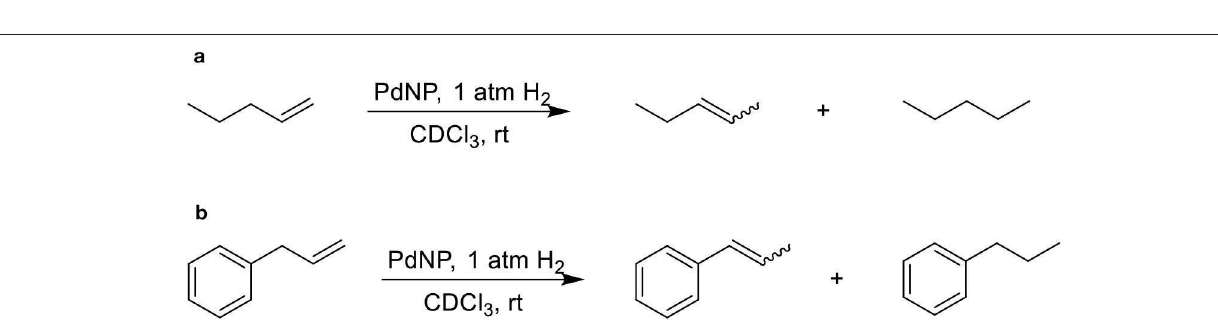
Frontiers in Chemistry |